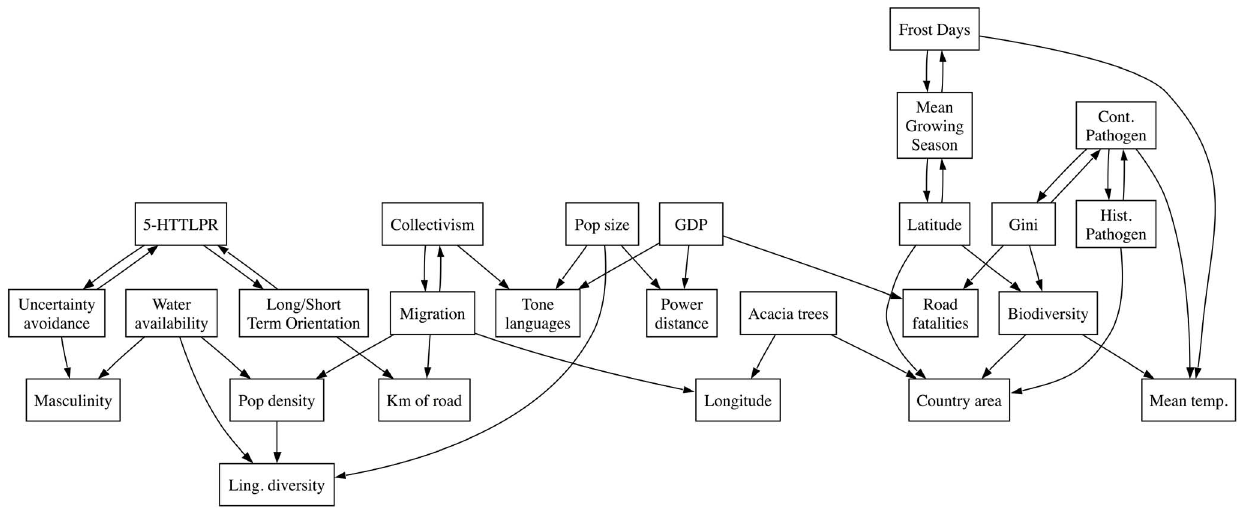
Figure 4. The most likely directed, acyclic graph of causal relationships between different variables in this study. Boxes represent variables and arrows represent suggested causal links going from a cause to an effect. See the methods section for details.